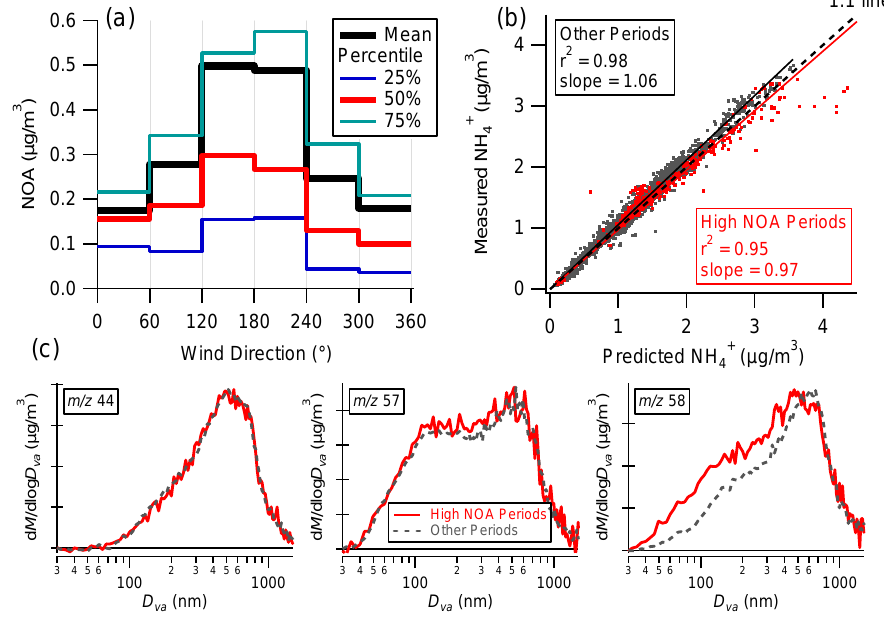
Fig. 14. (a) Statistical distributions of NOA concentrations corresponding to different wind sectors, (b) correlations between measured NH + and predicted NH + (=SO 2 − /96 × 36+NO − /62 × 18+Cl − /35.5 × 18; (Zhang et al., 2007b)) , and (c) average size distributions of m/z 44, 4 4 3 57, and 58 during high NOA periods vs. the rest of the times, respectively. The size distributions in (c) are all scaled to their corresponding maxima for better comparisons of peak shapes.